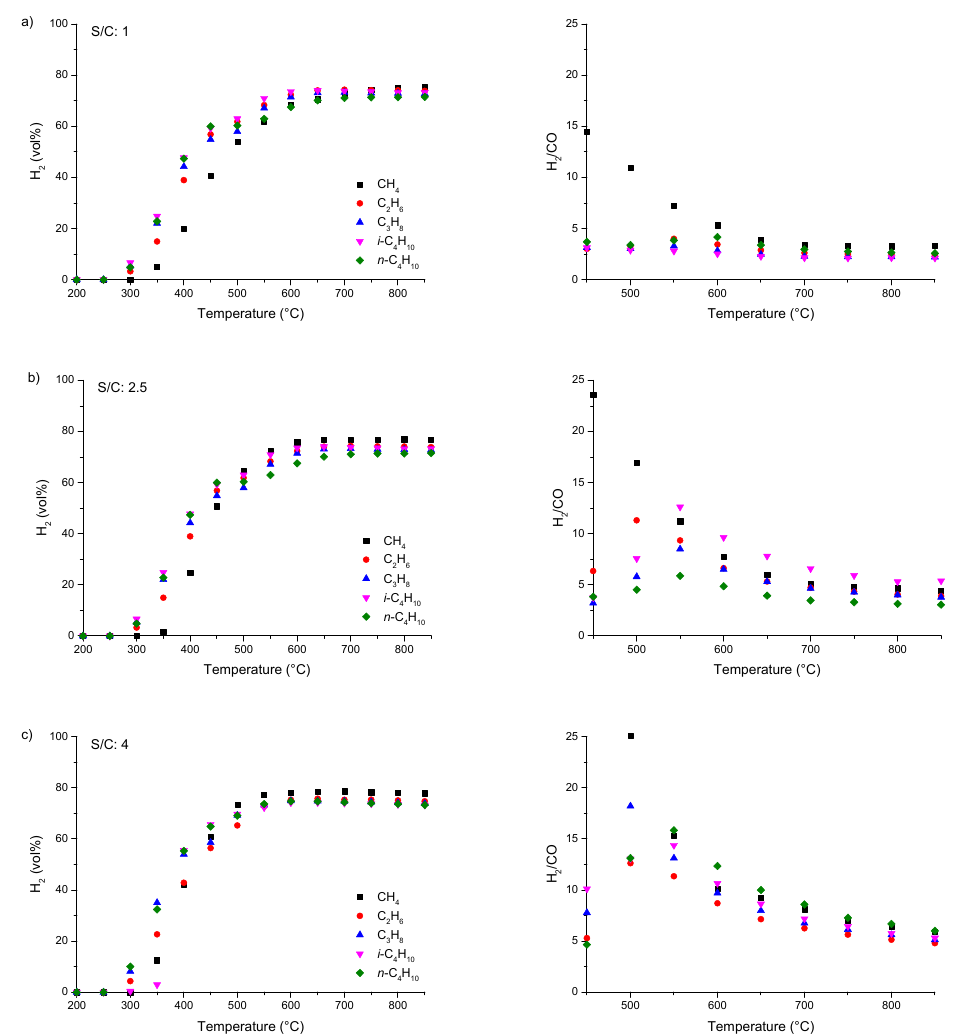
Figure 2. H 2 volumetric gas content (water and inert gas excluded) and H 2 /CO ratio in the steam reforming of single alkanes over Rh1/Al 2 O 3 at GHSV (gas hourly space velocity) of 8000 h − 1 and different values of temperature and S/C ratios of ( a ) 1, ( b ) 2.5, and ( c ) 4.